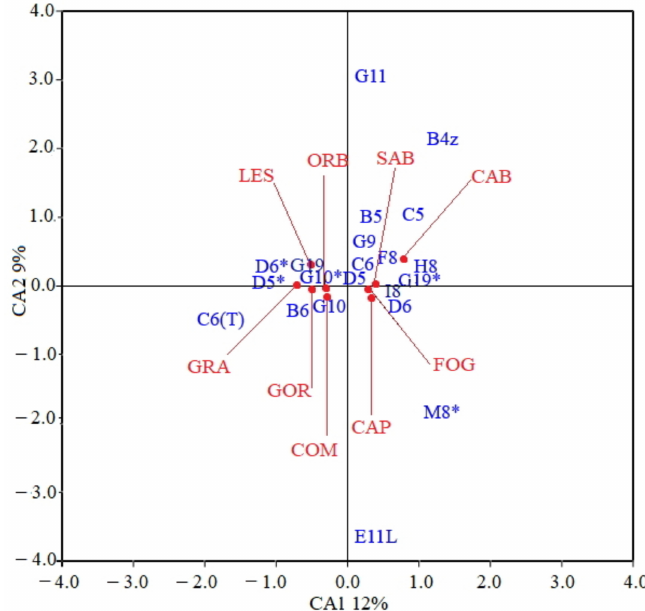
Figure 5. Correspondence analysis (CA), ordination of samples in the first two factorial axes (CA1 and CA2) plane. These axes account for 21% of total variance. Skeletal anomalies: malformed zygapoph- ysis of abdominal vertebrae (B4z), malformed neural and hemal elements associated to abdominal vertebrae (B5, B6), malformed neural and hemal elements associated to hemal vertebrae (C5, C6), tulip-like shaped hemal arch of hemal vertebrae (C6T), malformed neural and hemal elements associated to caudal vertebrae (D5, D6), supernumerary neural and hemal elements associated to caudal vertebrae (D5*, D6*), malformed rays of left pectoral fin (E11L), malformed pterygiophore of the anal fin (F8), malformed hypural (G9), malformed or hypermineralized epural (G10, G10*), malformed caudal fin rays (G11), hypural with demineralization (G19), hypermineralized hypural (G19*), malformed pterygiophore of the first and second dorsal fin (H8, I8), malformed interdorsal elements. Sites: (ORB) Orbetello, (CAB) Cabras, (FOG) Fogliano, (CAP) Caprolace, (SAB) Sabaudia, (LES) Lesina, (COM) Comacchio, (GOR) Sacca di Goro, (GRA) Grado